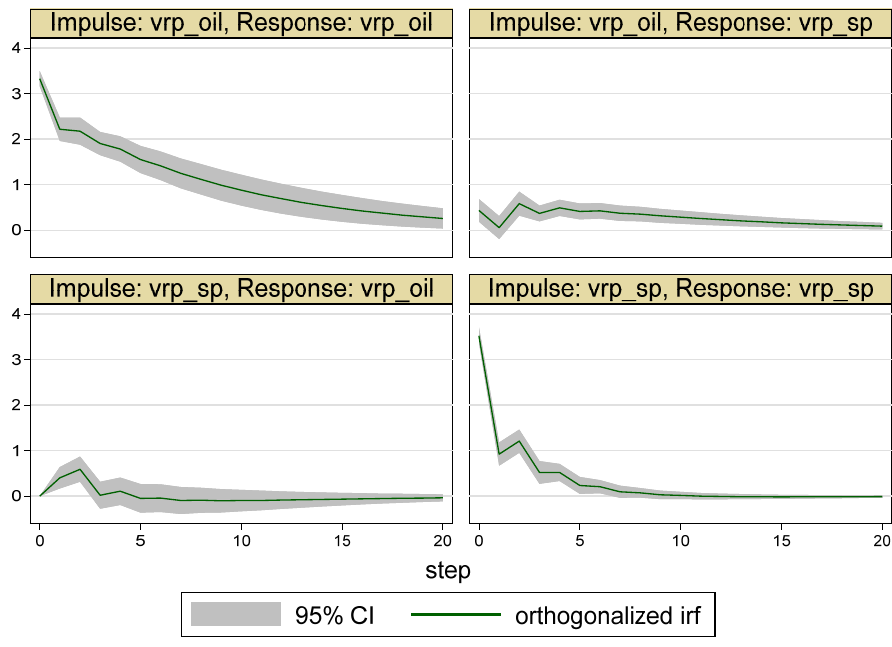
Figure 7. Impulse Response Function (Period 4).